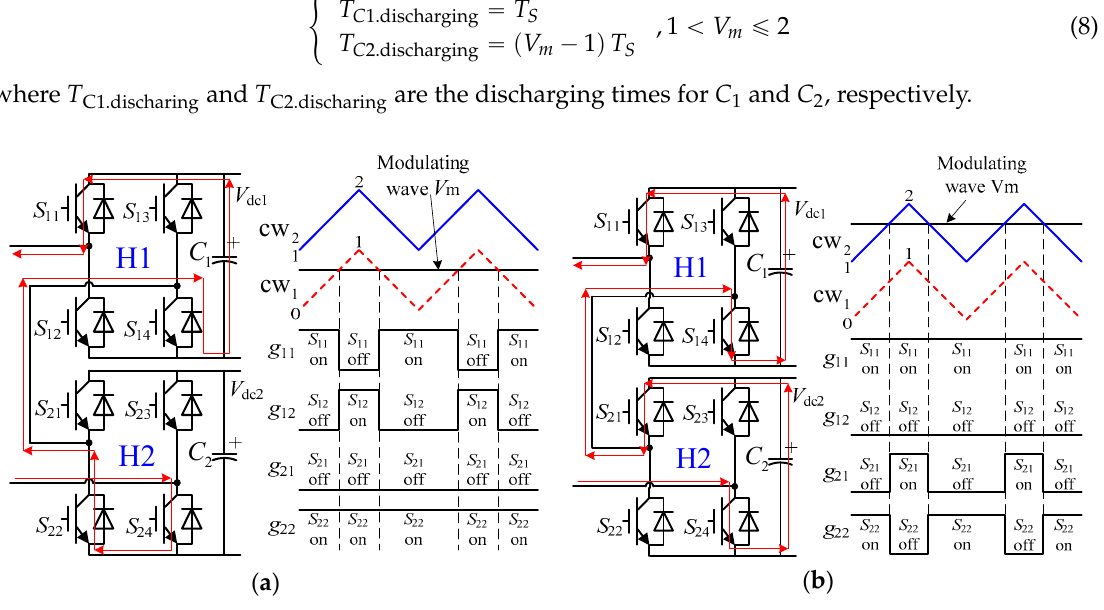
Figure 4. Principle of improved PD-PWM for DC-link voltage balancing of cascaded H-bridge rectifiers ( I dir < 0). ( a ) Modulating wave during [0, 1]; ( b ) Modulating wave during [1, 2].